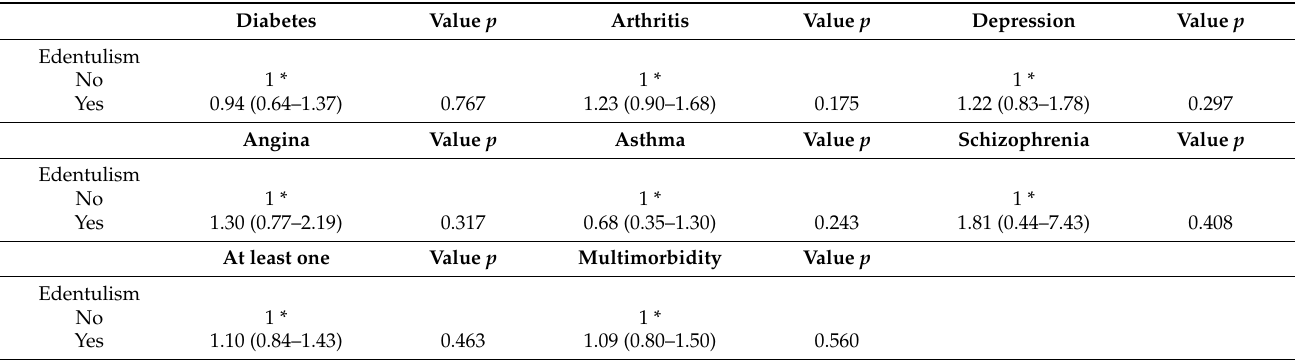
Table 2. Crude estimates (Odds ratio= OR, 95% confidence interval=95% CI) of the different chronic diseases, mental disorders and multimorbidity (2 or more chronic diseases at the same time) and edentulism in Mexican older adults.